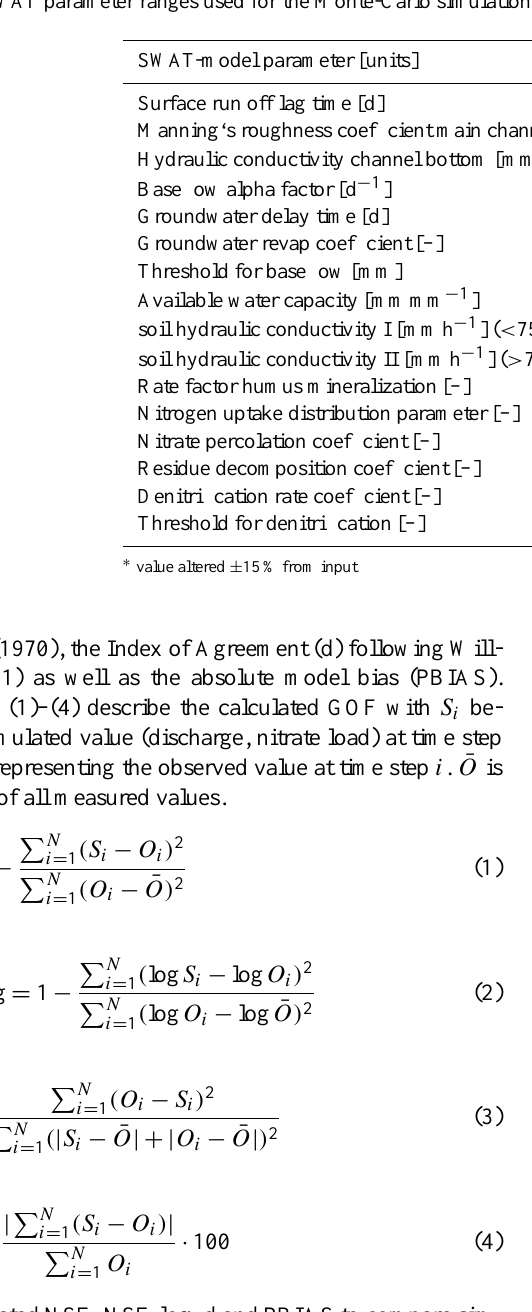
Table 1. SWAT parameter ranges used for the Monte-Carlo